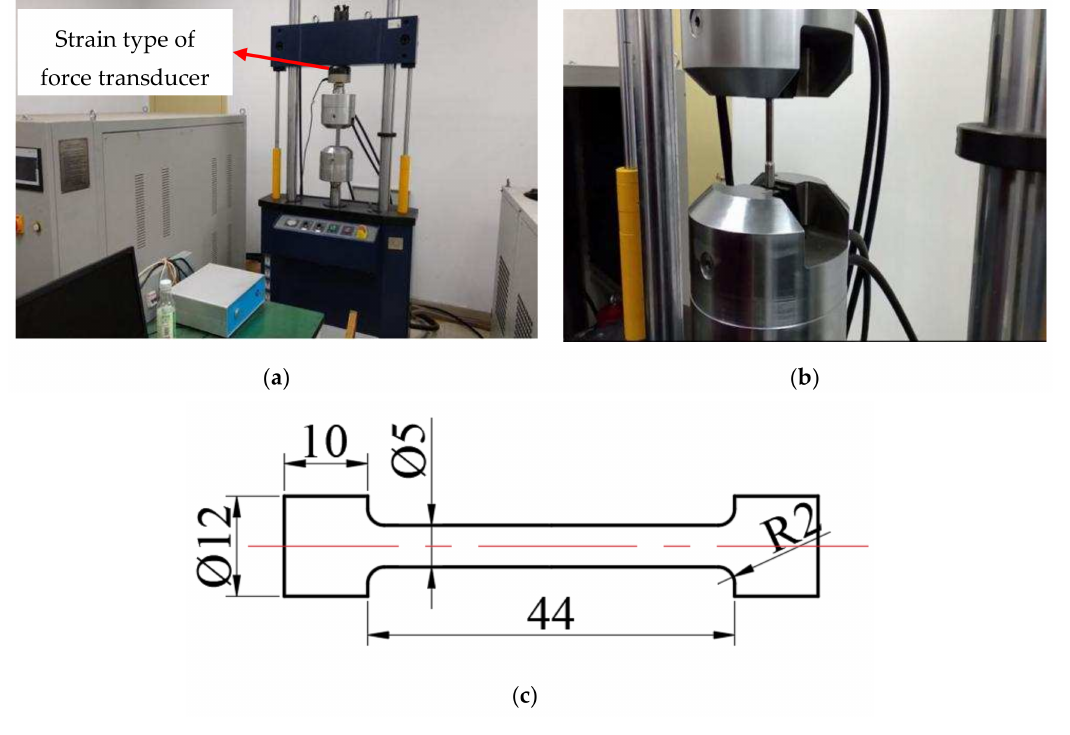
Figure 14. Loading and unloading experiments: ( a ) experimental equipment; ( b ) installation of the specimens; ( c ) size of the specimen. Table 3. Constitutive equation values of damping alloy loading curve.